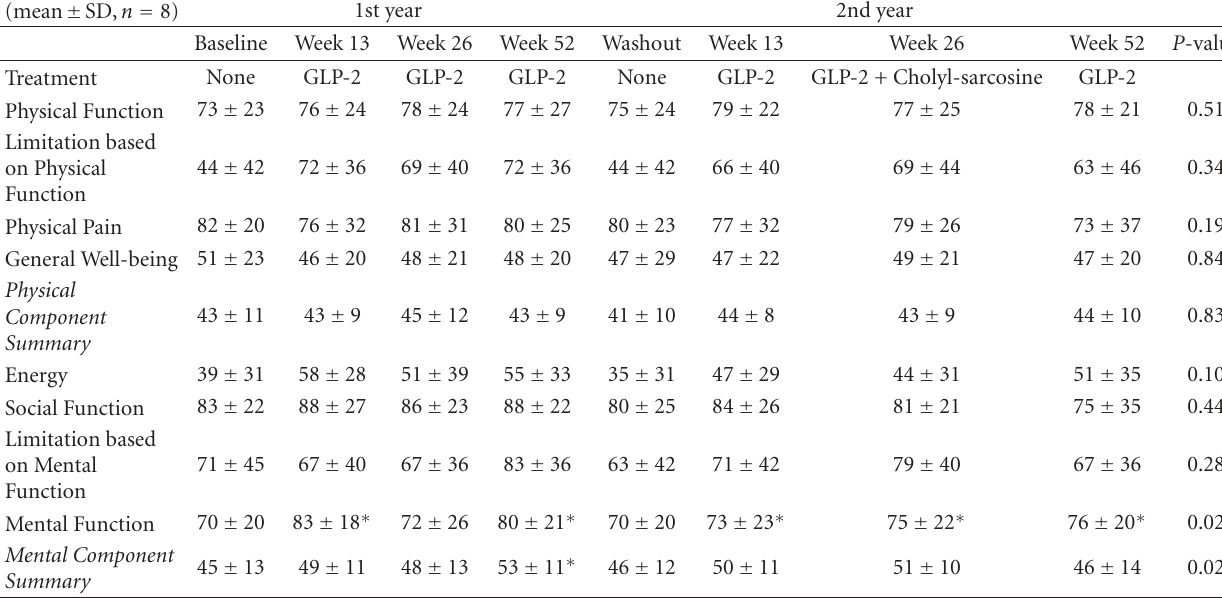
Table 3: Short form 36, SF-36 (100% ∼ Best).